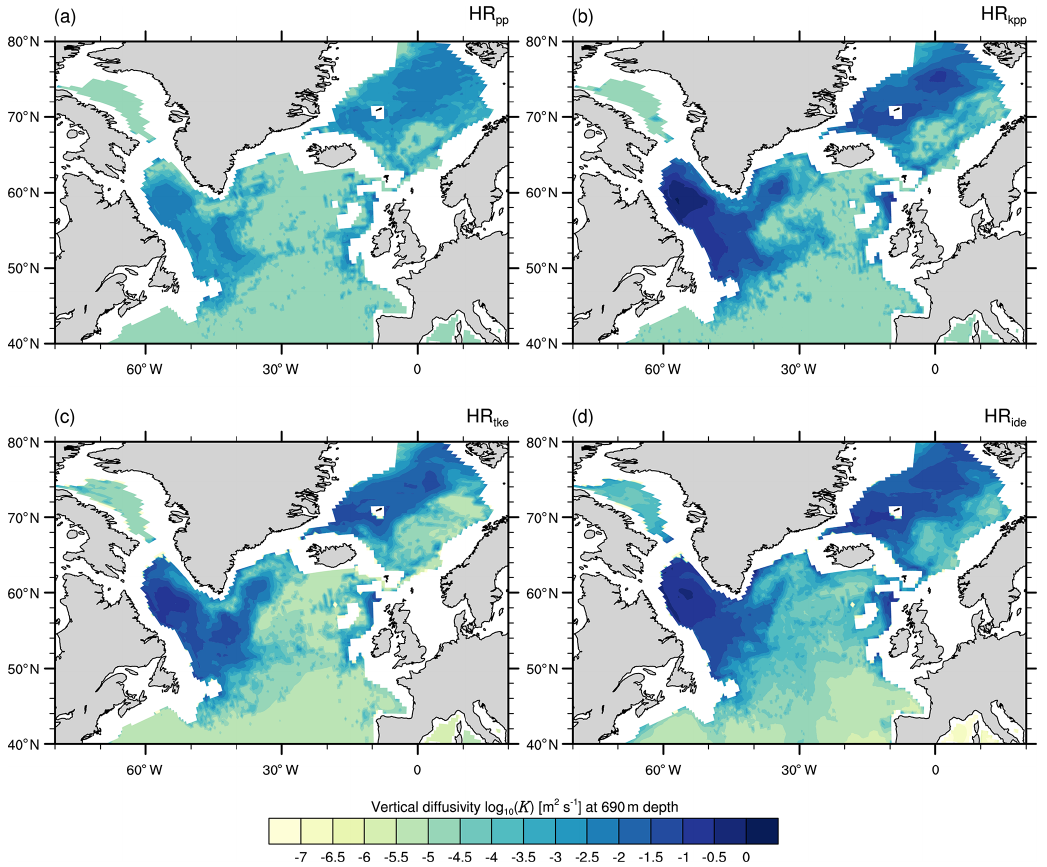
Figure 11. Time-averaged vertical diffusivity log 10 (K) (m 2 s − 1 ) at a depth of 690m in the subpolar North Atlantic simulated by MPI- ESM1.2 (a) HR pp , (b) HR kpp , (c) HR tke , and (d) HR ide